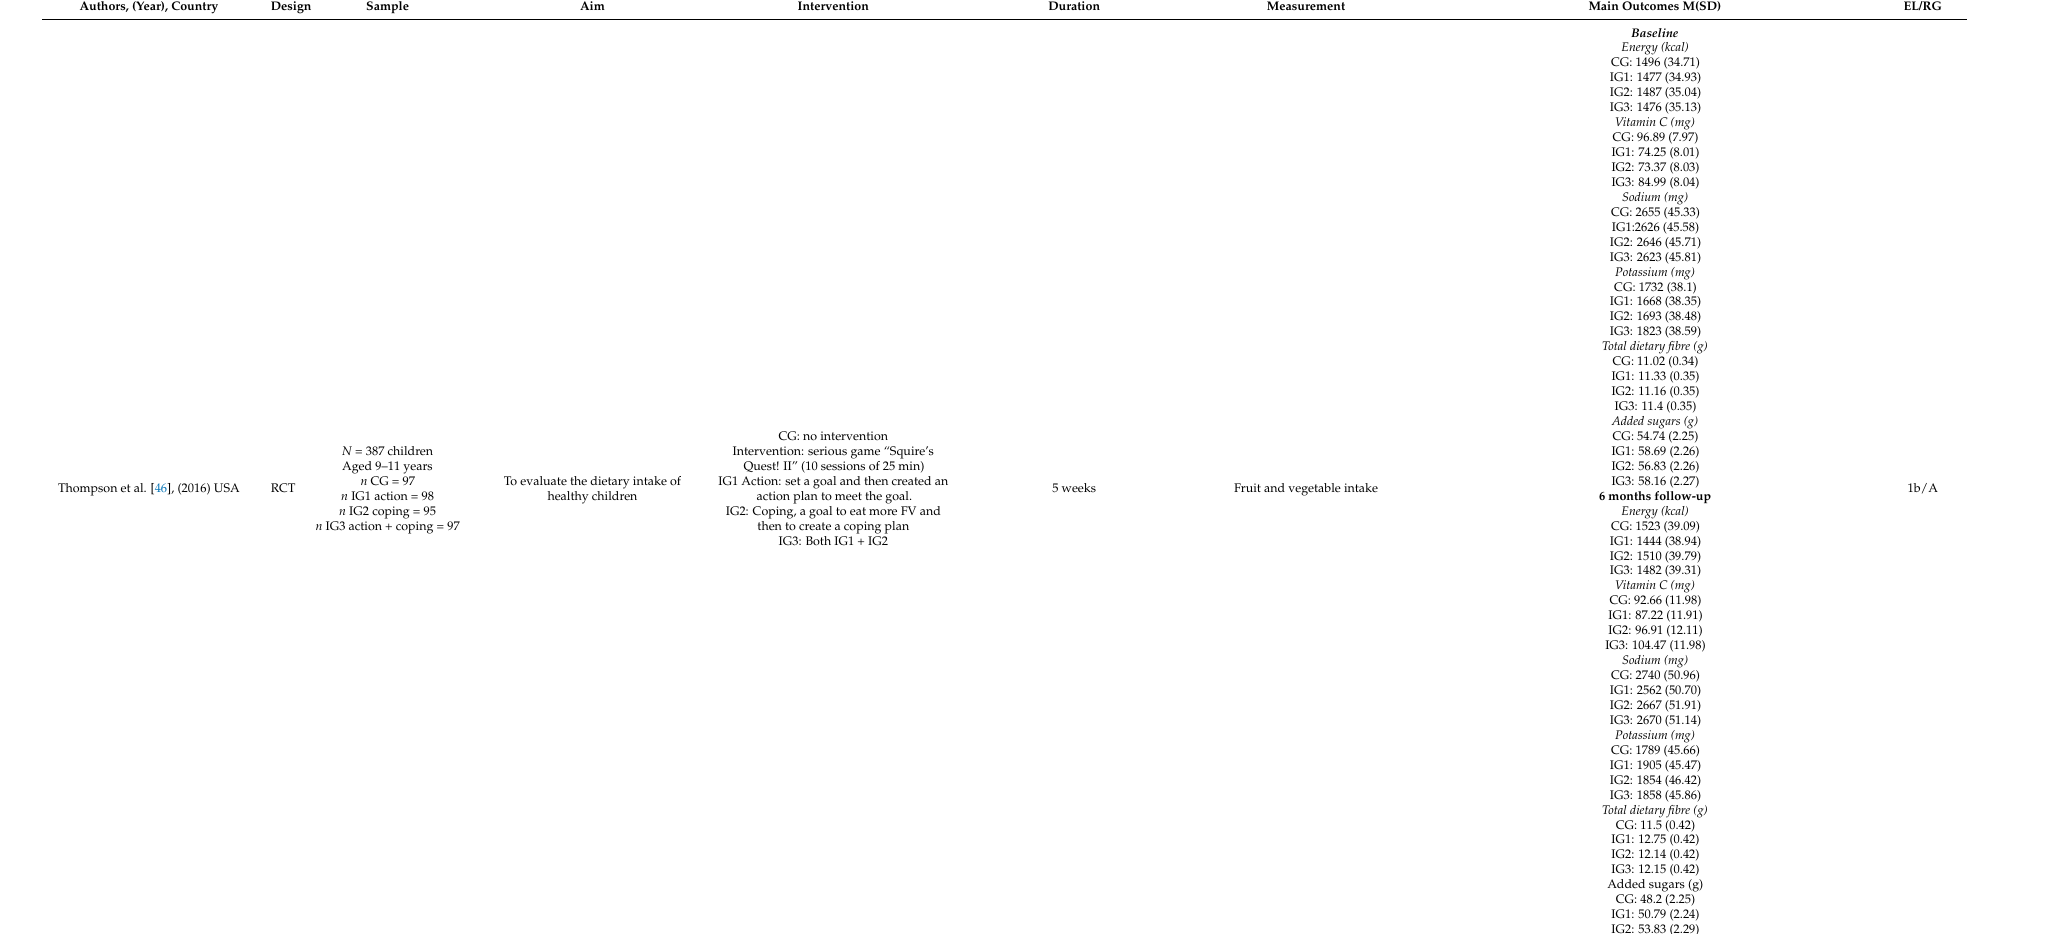
5weeks Fruitandvegetableintake